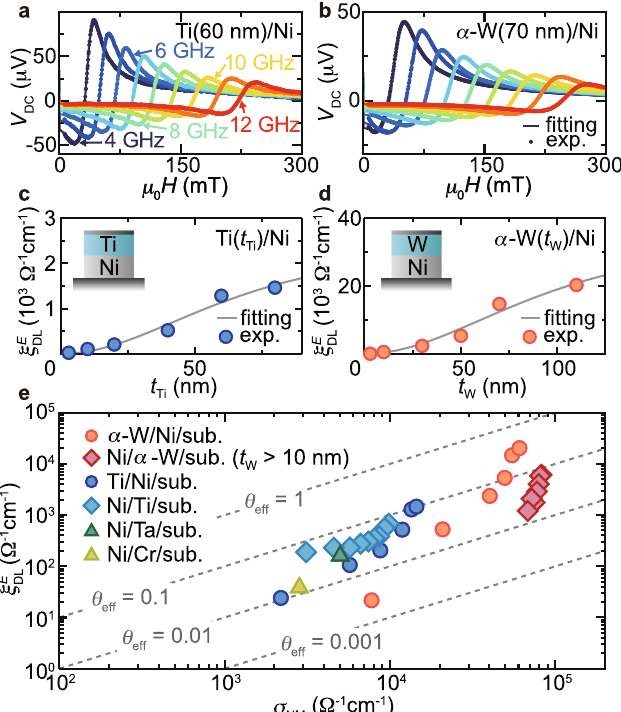
Fig. 5 Relation between orbital torque ef fi ciency and electric conductivity. Magnetic fi eld H dependence of the DC voltage V DC for the ( a ) Ti(60 nm)/Ni(8 nm) and ( b ) α -W(70 nm)/Ni(8 nm) fi lms with an applied RF power of 100 mW at different frequencies f . c Ti-layer-thickness t Ti dependence of ξ E Ti( t Ti )/Ni(8 nm) bilayer. d W-layer-thickness t W dependence of ξ E solid curves are the fi tting result assuming that the orbital Hall conductivity is independent of t NM . e The DL-torque ef fi ciency ξ E longitudinal electric conductivity σ NM for all the devices investigated in this study. The data for the Ni/Ta and Ni/Cr structures are taken from published papers 30,31 . The dotted lines are the effective Hall angles θ the